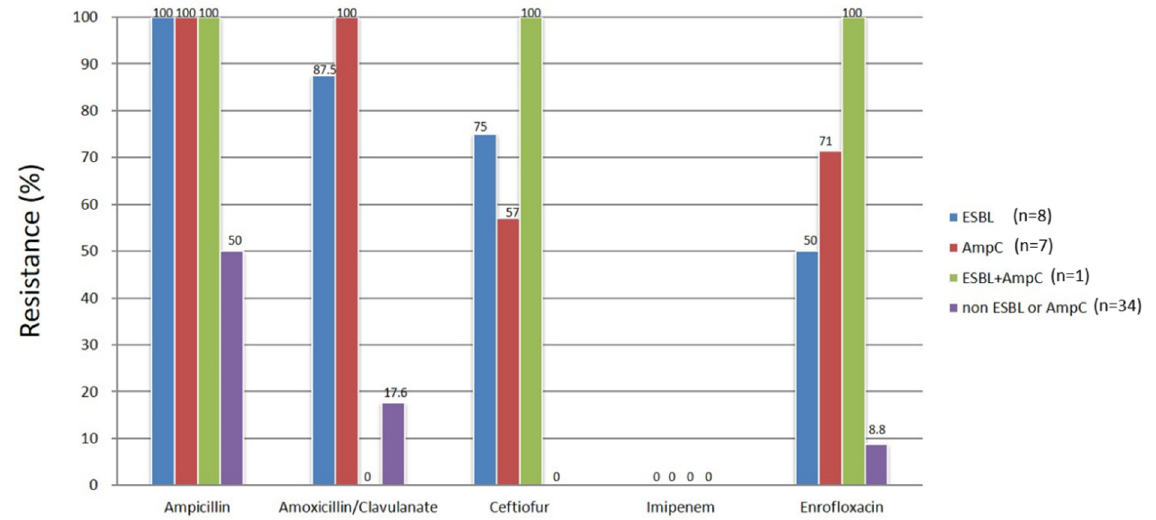
Figure 2. Antimicrobial susceptibility tests of E. coli containing ESBL, pAmpC, both, or neither. E. coli isolates that possess only ESBL, only pAmpC, both ESBL and pAmpC, and neither of the ESBL and pAmpC genes are represented by separate colors. The numbers adjacent to the end of the bars denote the percentage of resistance.